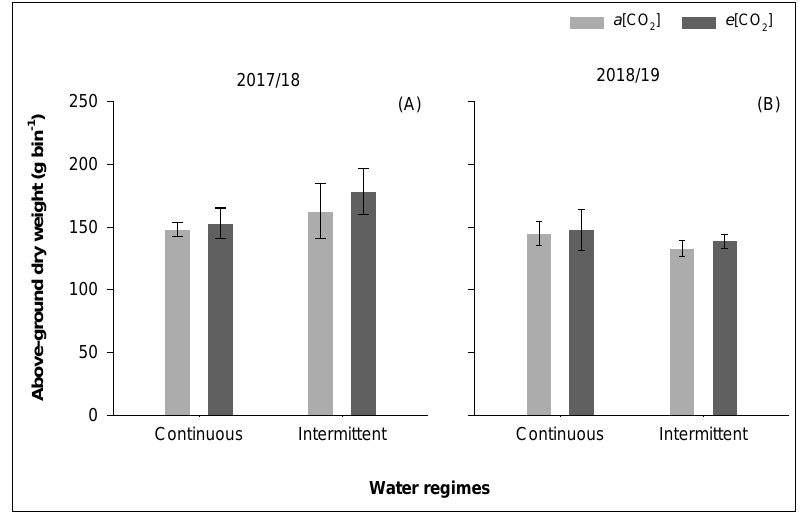
Figure 4. Effect of atmospheric CO 2 concentrations ( a [CO 2 ] = 400 μmol mol −1 and e [CO 2 ] = 700 μmol mol −1 ) and irrigation water regimes (continuous vs. intermittent flood) on the aboveground dry weight of rice grown in open-top chambers in 2017/18 ( A ) and 2018/19 ( B ) growing seasons. Error bars correspond to 95% confidence intervals.